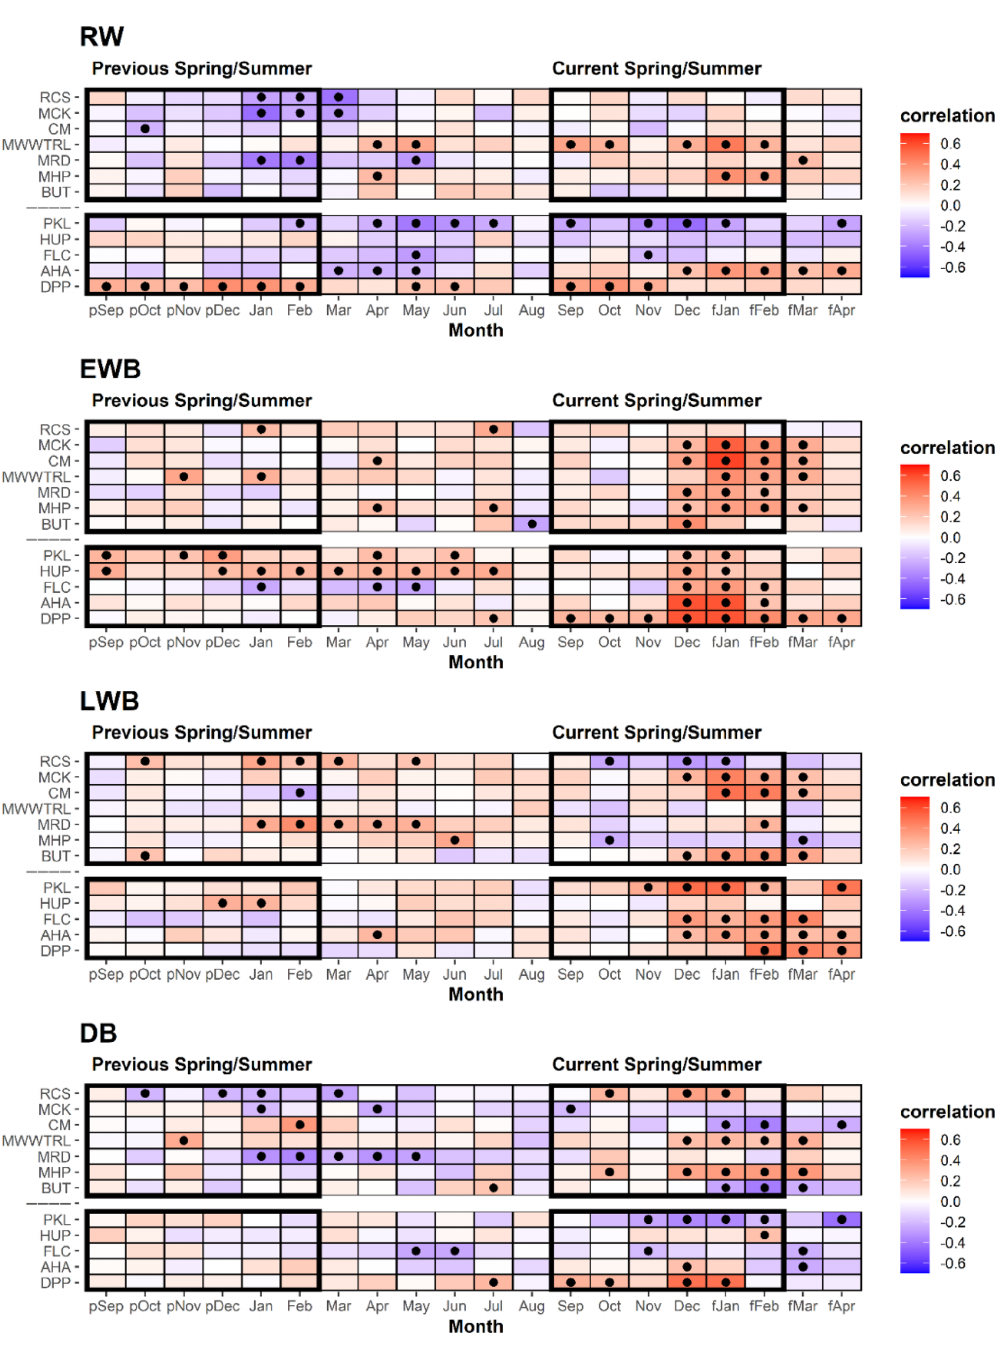
Table 2. Correlation response function analysis results for the different tree-ring parameter chronologies with CRUTS temperatures. Analysis undertaken over the 1902–1995 period (see Fig. S3 for correlations for split periods 1902–1950, 1951–1995). The upper block is for the Tasmanian sites, while the lower block is New Zealand. See Table 1 for site code names and species. Black dots denote correlation significant at the 95% confidence